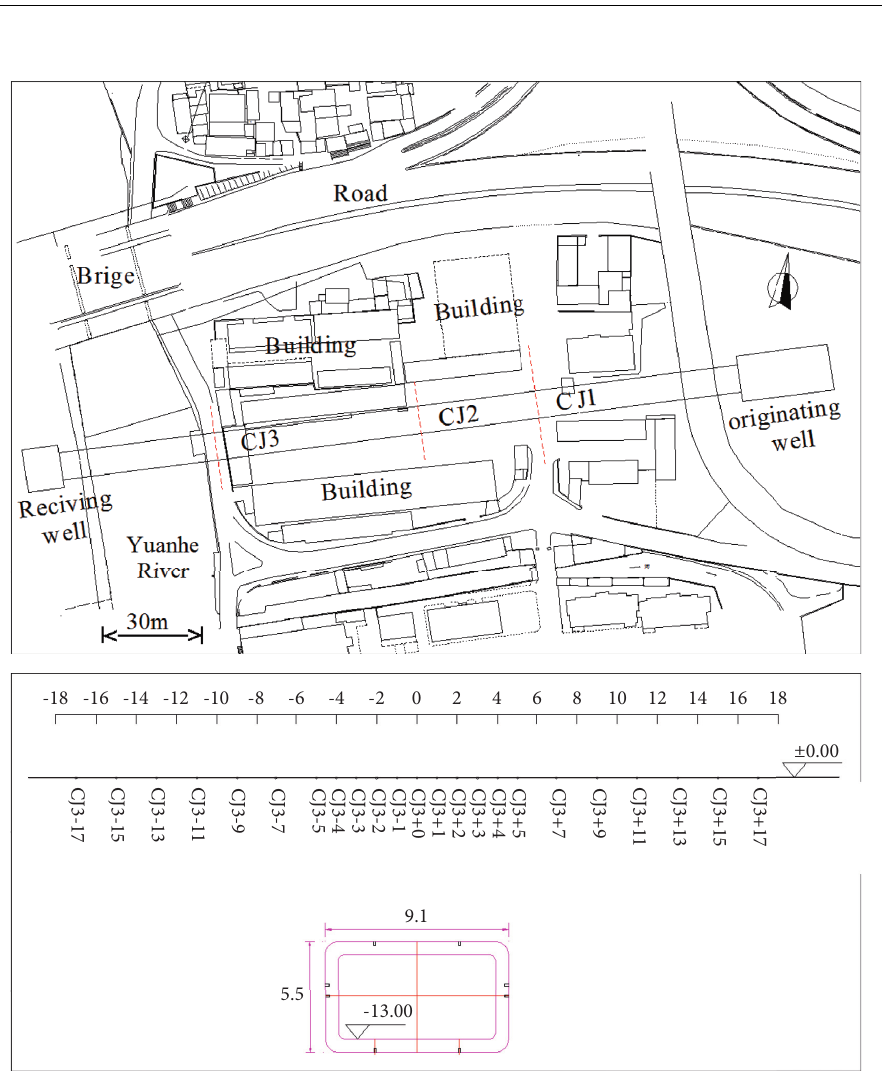
Figure 3: CJ3 plane layout of settlement monitoring points.